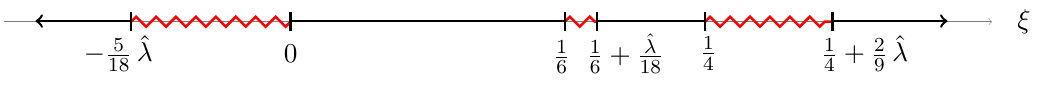
Figure 6 . The ANEC and unitarity bounds exclude certain ranges of ξ , in red zig-zag lines, below ξ = 0 , above ξ = 1 / 6 , and above ξ = 1 / 4 , when d = 4